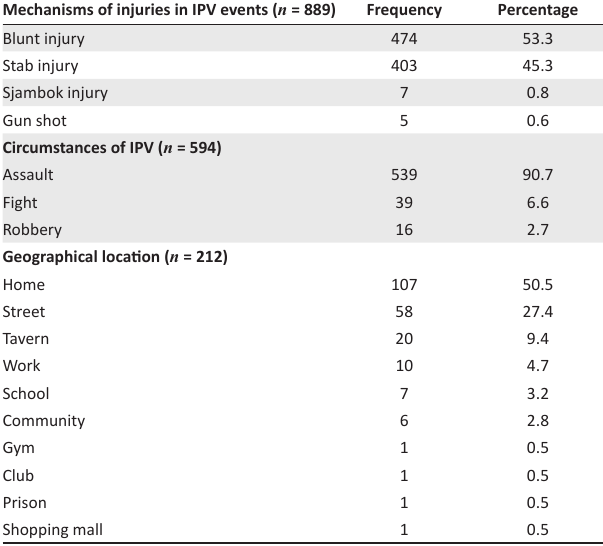
TABLE 2: Mechanisms of injury, circumstances and geographical location of interpersonal violence.